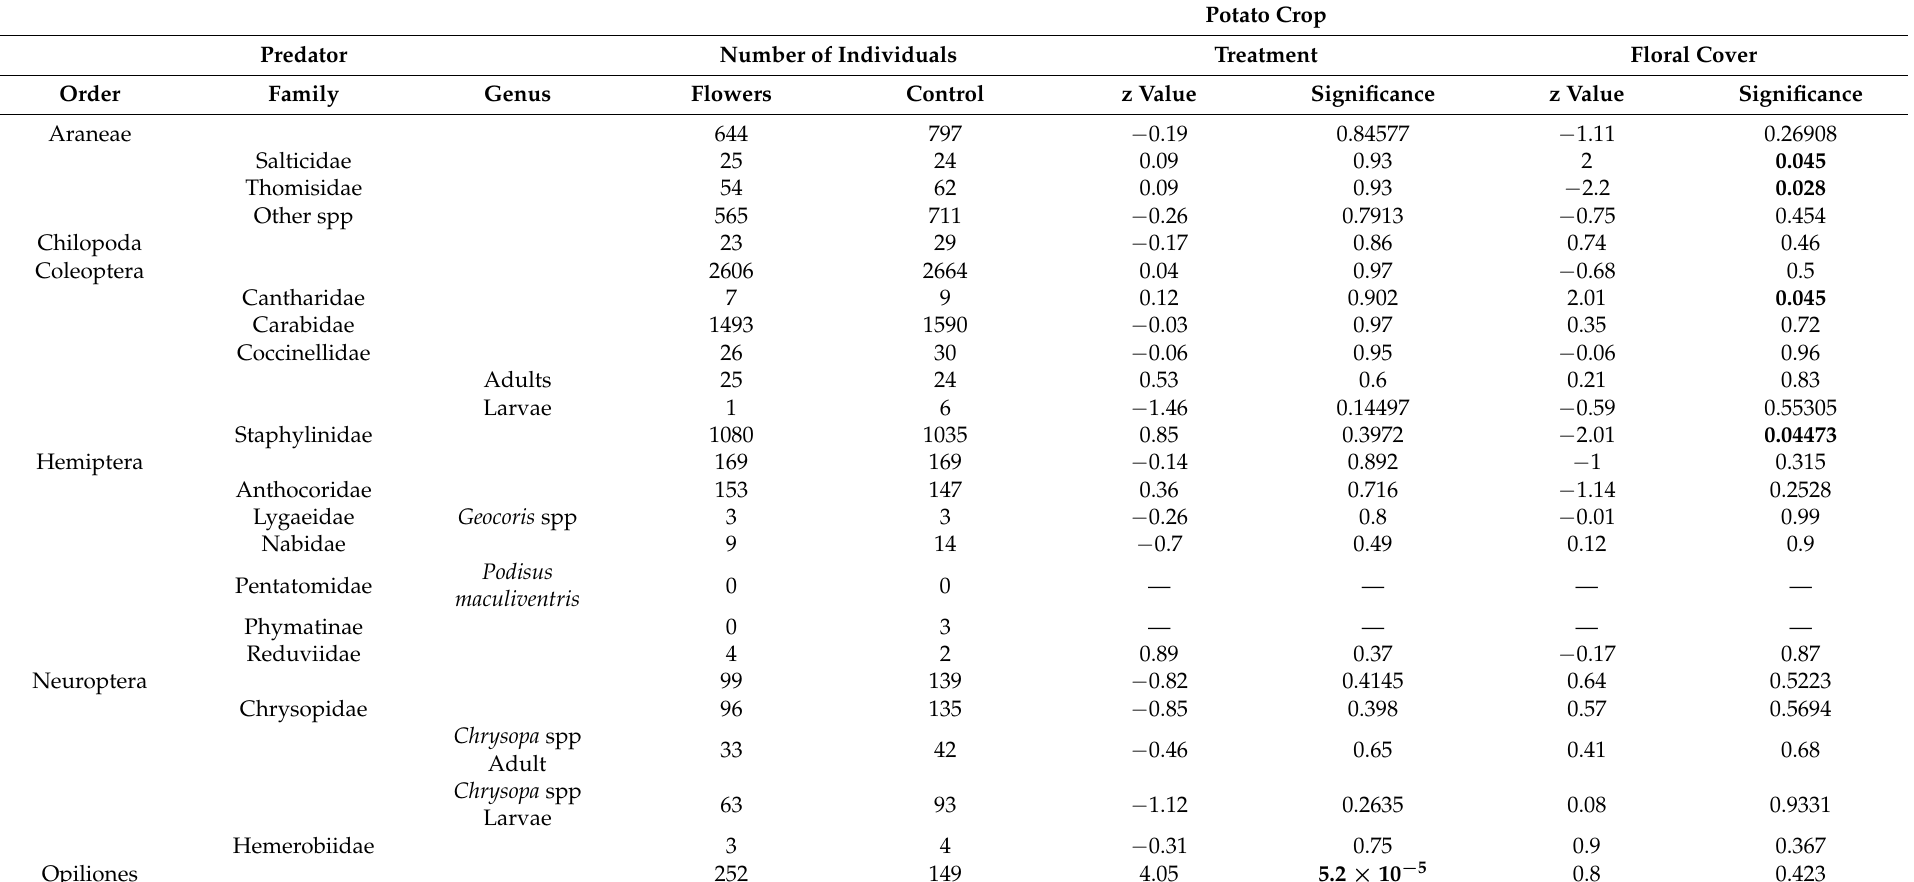
Table 3. Predator abundance, z values, and significance by treatment and floral cover within potato crops. Bolded values are significant ( p < 0.05). Taxa with fewer than 10 individuals were not